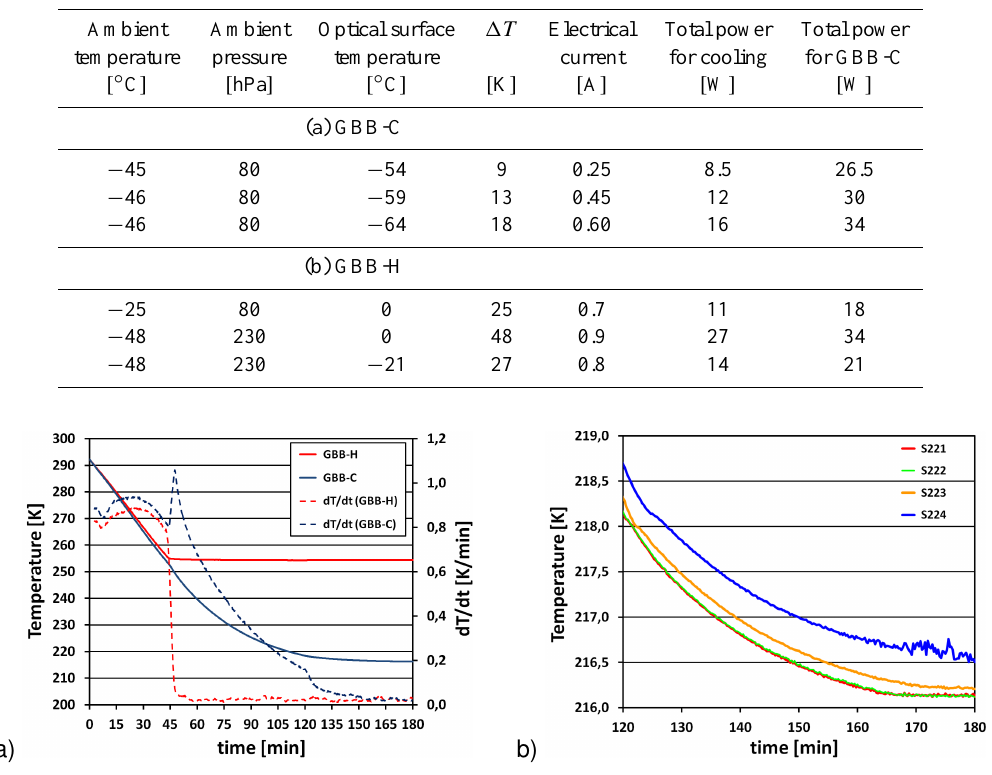
Table 6. Power required for GBB optical surface temperature stabilisation.